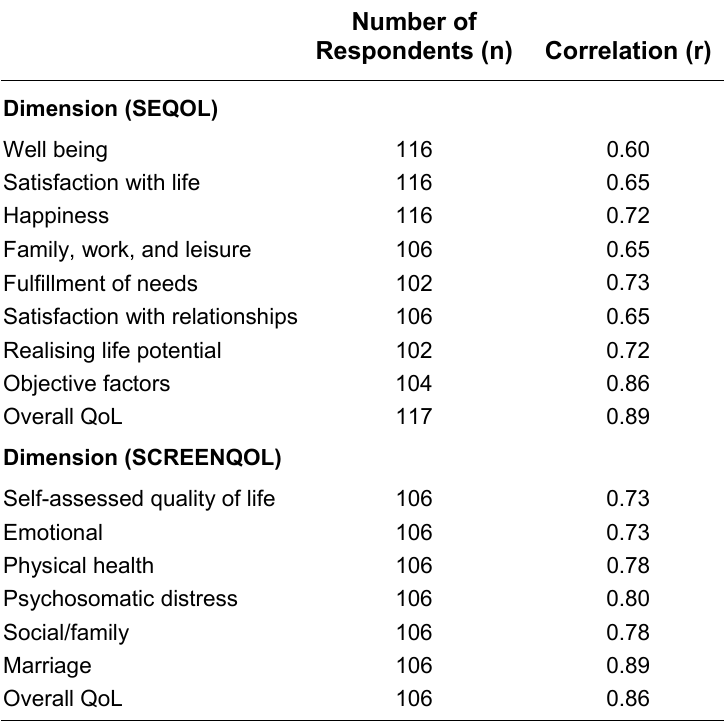
Reliability, SEQOL (Test-Retest D28) and SCREENQOL (Test-Retest